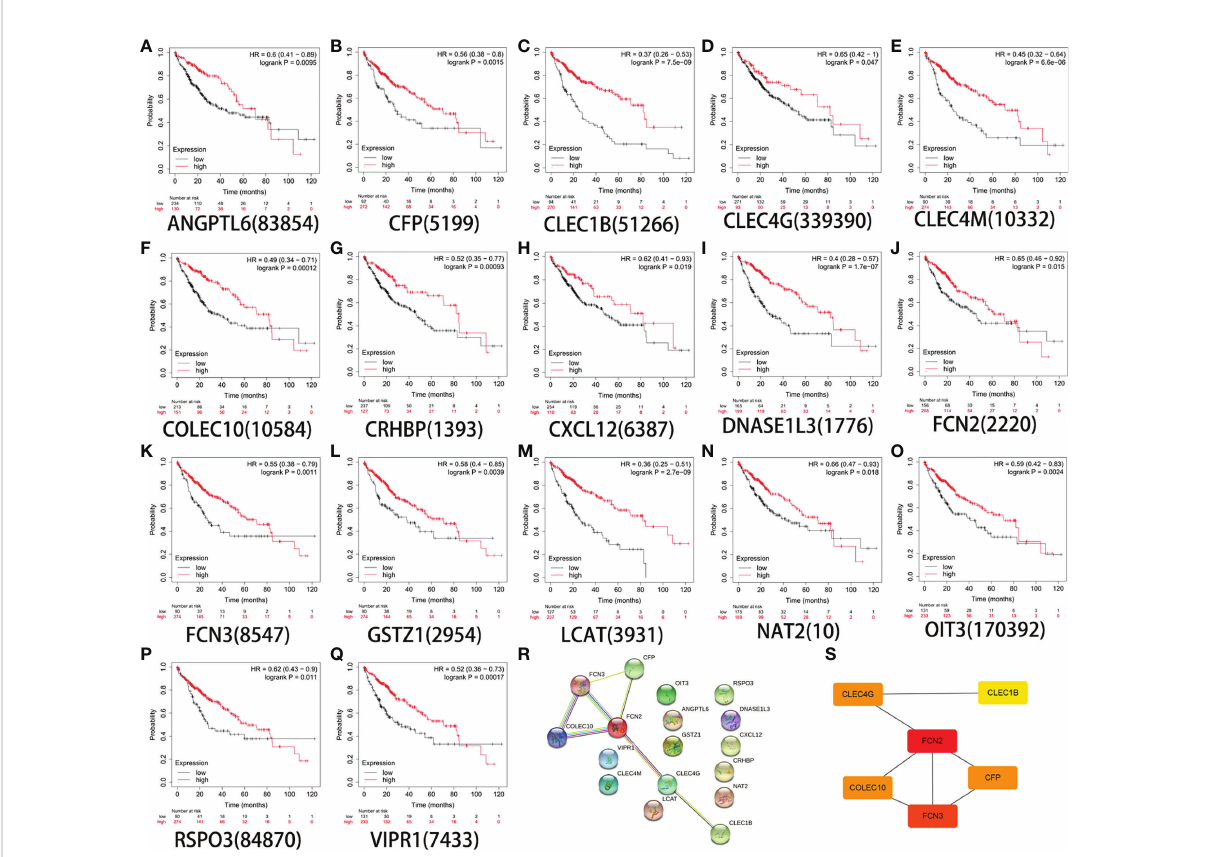
(Figure 5G). Normal liver tissues had an average positive area of 1,783,320.5318 m 2 and an average optical density of 0.25662176264, while tumor tissues had an average positive area of 1,357,014.3320 m 2 and an average optical density of 0.16741577631. The normal and tumor groups had signi fi cance values of 0.200 and 0.086, respectively, suggesting that the positive staining area followed a normal distribution. Analysis of the t -test results revealed a signi fi cance of 0.036 (0.05), suggesting that the two sets of data are quite dissimilar and that the positive staining zone of the cancer group is smaller than that of the normal group (Figure 5H). The expression of FCN2 mRNA in liver tumor cell lines was shown to be at a low level using RNA sequencing (RNAseq) (Attachment 1). Affymetrix analysis exhibited the expression of FCN2 mRNA in all tumor cell lines to be above 3.2. These studies have con fi rmed the signi fi cantly low expression of FCN2 in liver cancer tissues from different databases, as well as mRNA, protein, and clinical